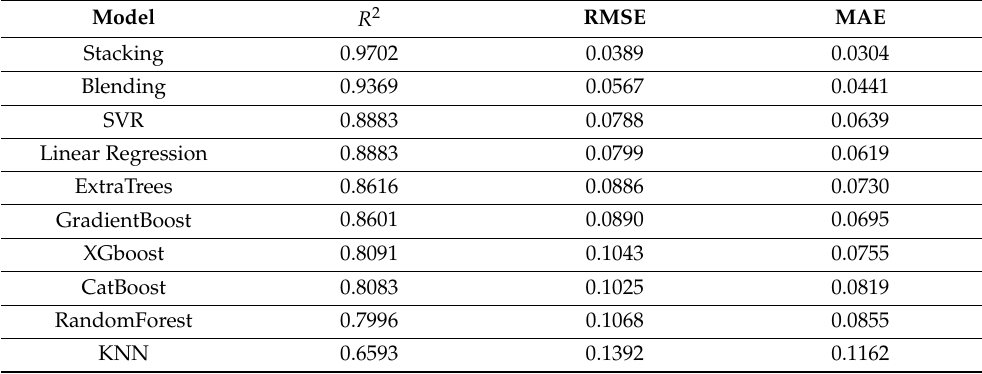
Table 11. Comparison of single model, blending ensemble model, and stacking ensemble